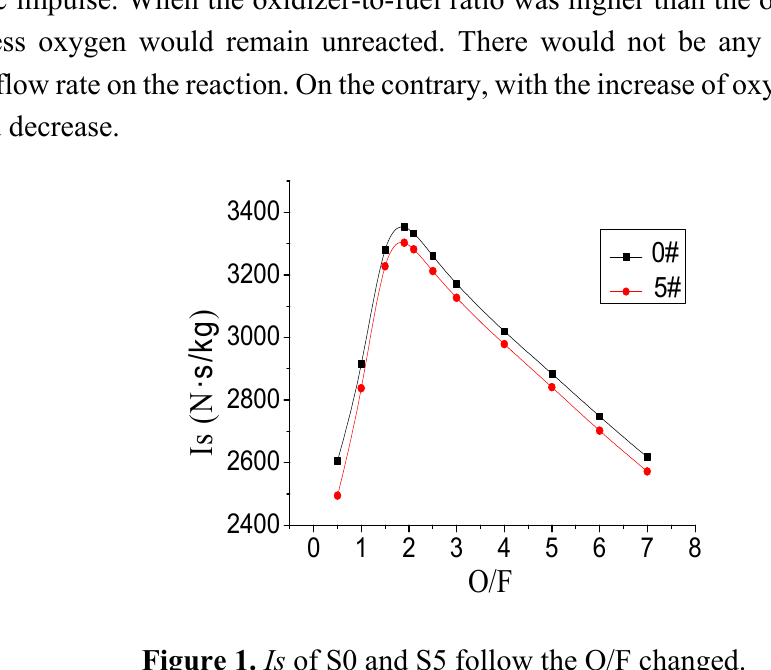
Figure 1. Is of S0 and S5 follow the O/F